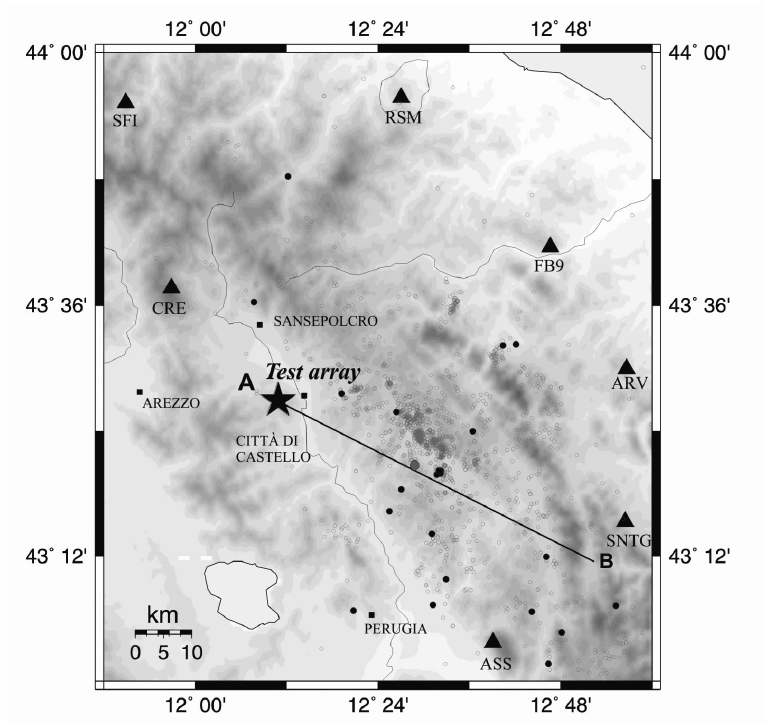
Fig. 1. Location of the test array site near Città di Castello (asterisk). Triangles indicate the locations of the RSNC-stations during the CDC-array experiment. The epicentres of the local seismic events recorded during the array experiment are plotted with black dots; the grey dots represent the background seismicity as recorded dur- ing the following month by a dense local seismic network (2nd field experiment). The line A-B indicates the di- rection of the section shown in fig.